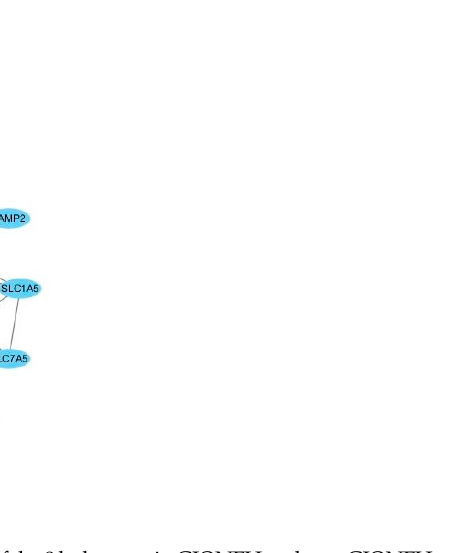
Figure 4. Theprotein–proteininteractionnetworkofthe8hubgenesinGIONFHandnon-GIONFHsamples. Figure 4. The protein–protein interaction network of the 8 hub genes in GIONFH and non-GIONFH samples.